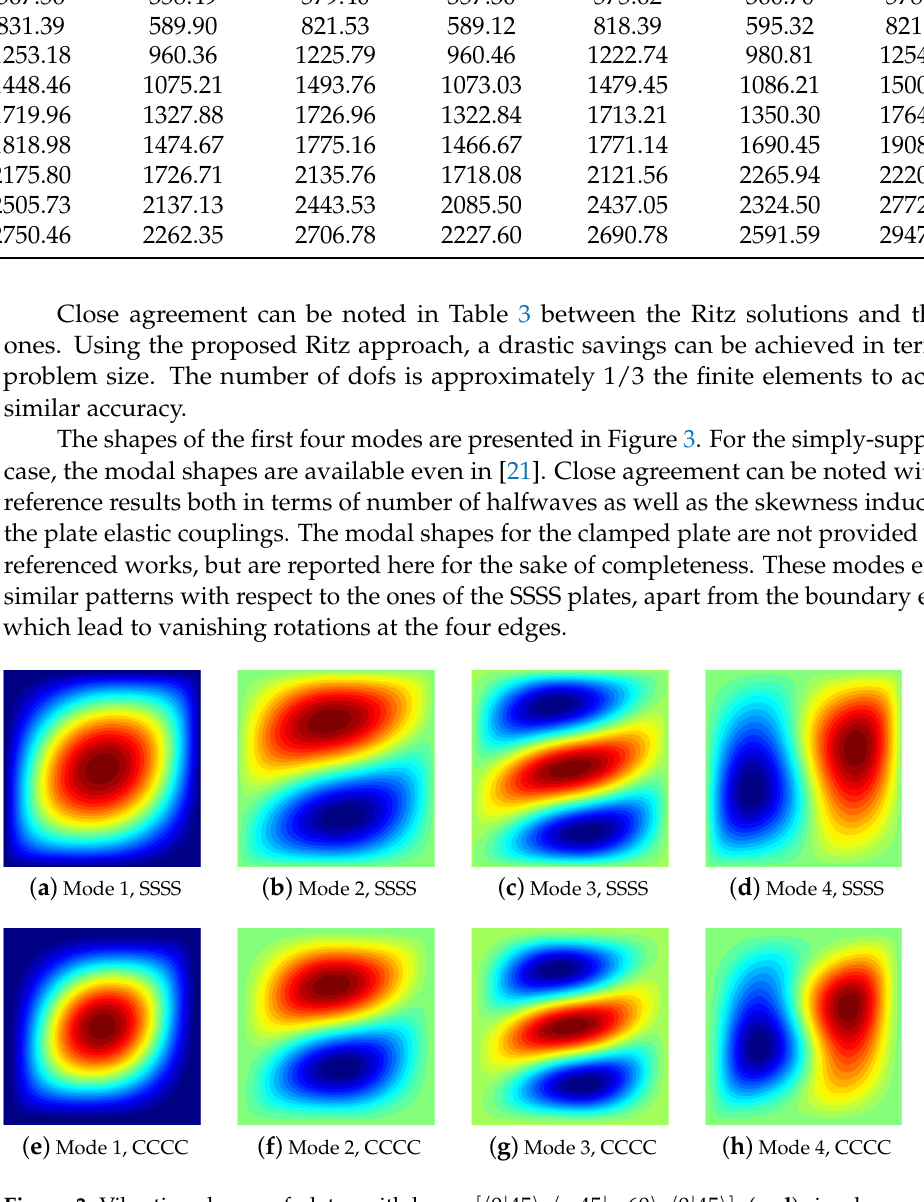
Figure 3. Vibration shapes of plates with layup [ (cid:104) 0 | 45 (cid:105) , (cid:104)− 45 |− 60 (cid:105) , (cid:104) 0 | 45 (cid:105) ] : ( a – d ) simply-supported; ( e – h )